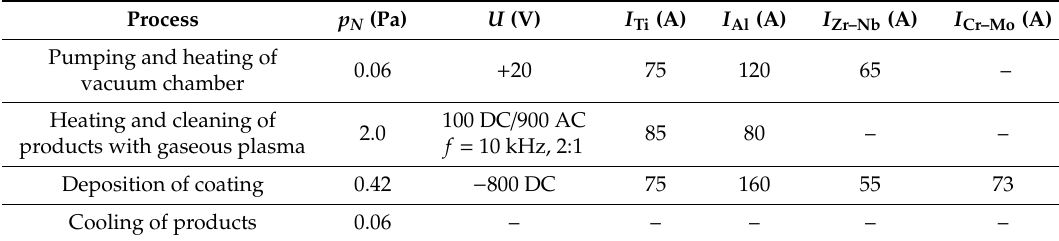
Table 1. Parameters of stages of the technological process of the deposition of coatings.